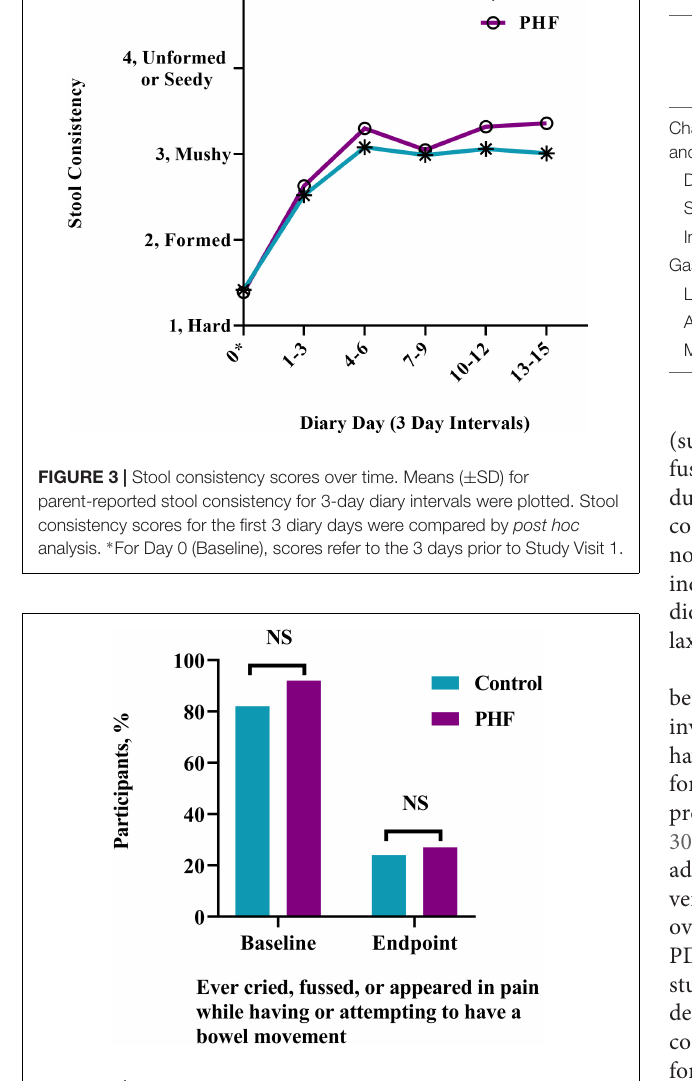
FIGURE 4 | Participants (%) who ever cried, fussed or appeared in pain while having or attempting to have a bowel movement at Study Baseline and Endpoint.